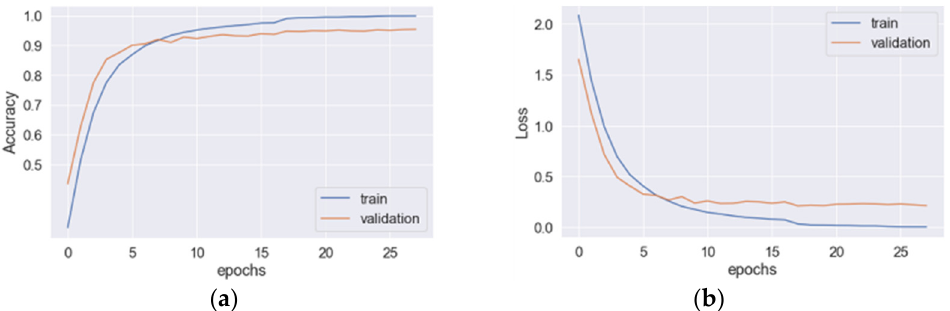
Figure 5. The learning curves for the hybrid CNN+BiLSTM model: ( a ) the accuracy and ( b ) loss curves.